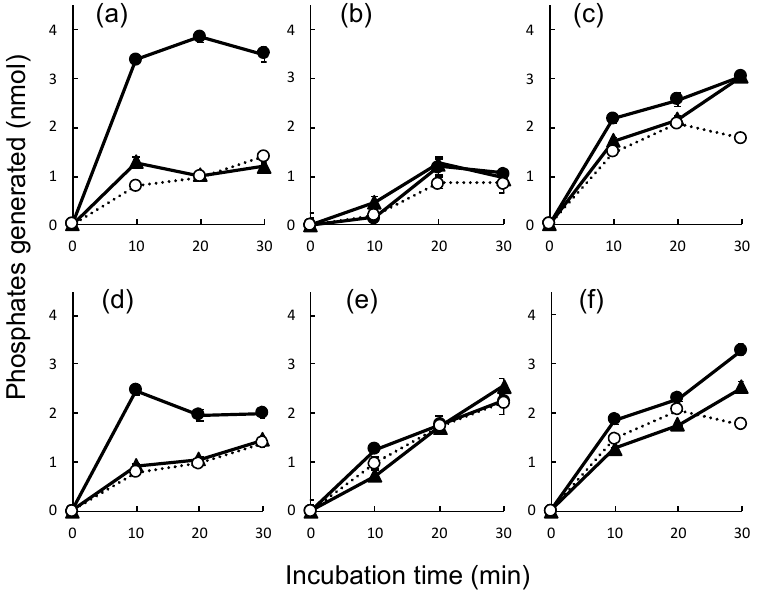
Figure 5. Double-stranded (ds) nucleic acid-dependent ATPase assays of the tagged Dicer-related helicase (DRH)-1, DRH-1 isoform b, and DRH-3. ATPase activities for 500 nM of the poly-histidine (His)-tagged DRH-3 ( a , d ), His-small ubiquitin-like modifier (SUMO)-tagged DRH-1 ( b , e ), and His-SUMO-tagged DRH-1 isoform b ( c , f ) were measured in the absence (open circles on dotted lines) or presence of dsDNA (closed triangles) and dsRNA (closed circles) using a QuantiChrom ATPase / GTPase Assay Kit, as described in the Materials and Methods section. Additions of 400 nM of short 30-nucleotide ds oligonucleotides and long ds polynucleotides (poly(A / U) and poly(dA / dT)) were made in the reactions shown in ( a – c) and ( d – f ), respectively. The reactions were performed in triplicate at 37 ◦ C for indicated periods, and the phosphate amounts generated in the reactions were plotted with the standard deviations.